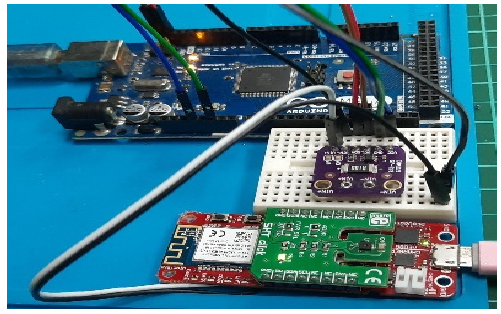
Figure 13. Current measurement process.